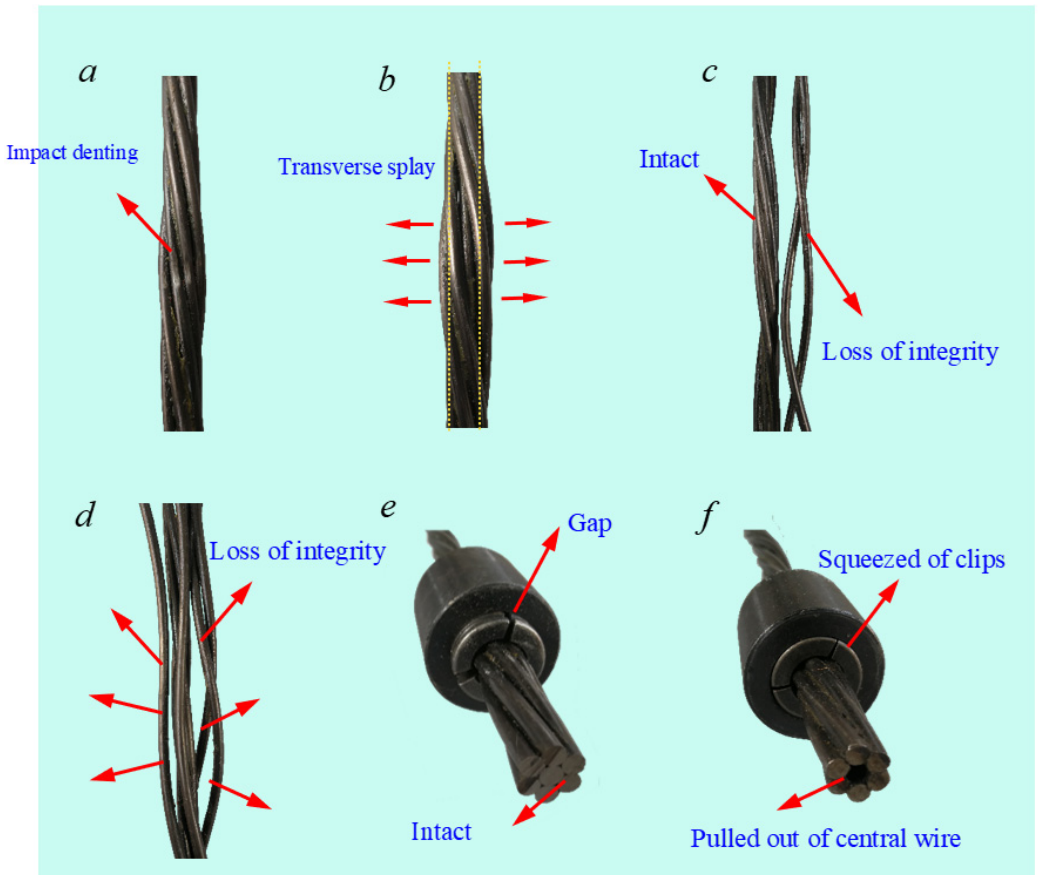
Figure 12. Local deformation of cable after impact: ( a ) impact denting on the upper surface of impact zone; ( b ) transverse splay on the impact zone; ( c , d ) partial or total loss of integrity near the root; ( e , f ) squeezing of clips and pulling out of the central wire.